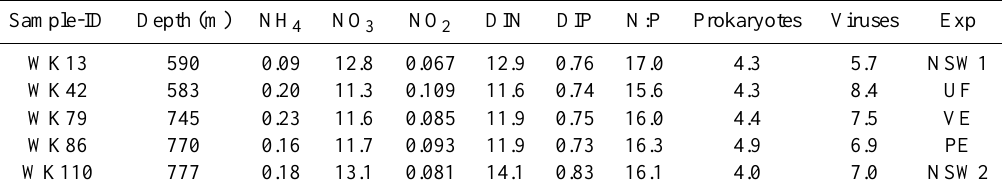
Table 1. In situ concentrations of nutrients and abundances of prokaryotes and viruses. Nutrients are given in µM, prokaryotes as 10 5 cellsml − 1 and viruses as 10 6 viruses ml − 1 . Exp, experiment; NSW, natural sea water; UF, ultrafiltrate; VE, virus-enriched; PE, prokaryote-enriched; DIN, dissolved inorganic nitrogen; DIP, dissolved inorganic phosphorus.